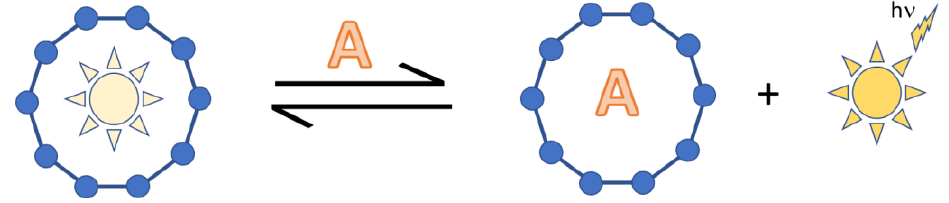
Figure 3. Schematic representation of a fluorescent indicator displacement assay.